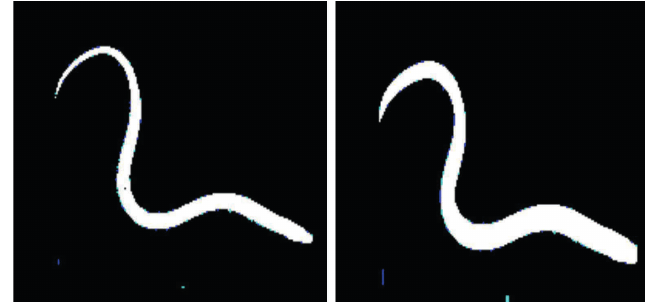
Fig. 4. Dimension of the photo box.